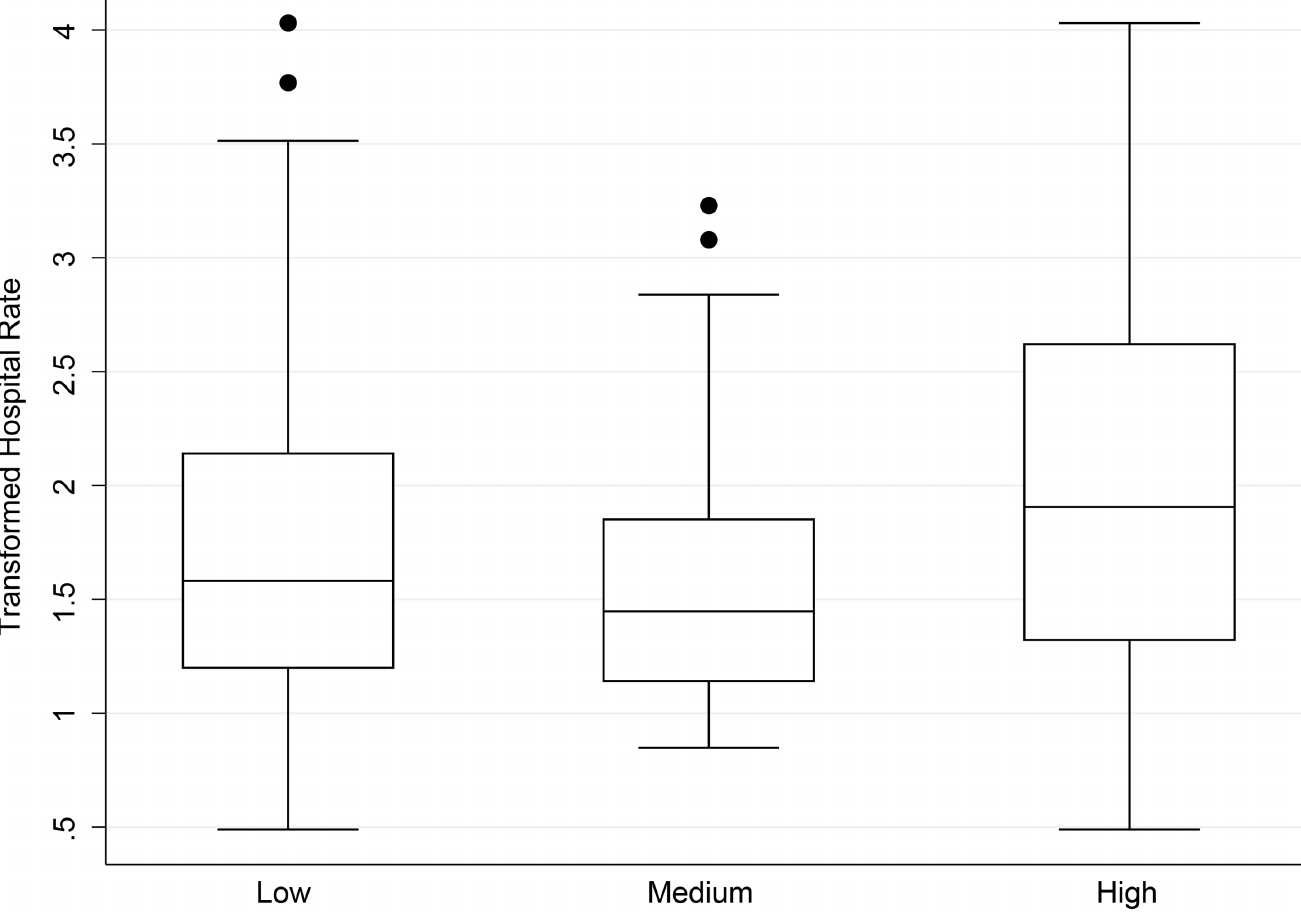
Fig 4. Box plots of hospital ARI rates per week per village cluster per 1,000 people by community health rate categories a . Dots represent outliers in the